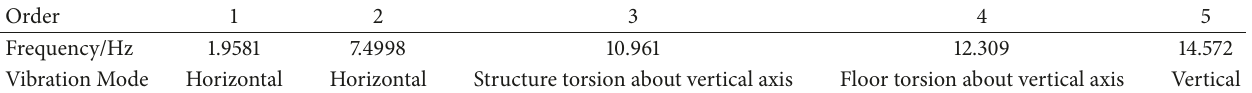
Table 5: The first five natural frequencies and corresponding vibration mode.